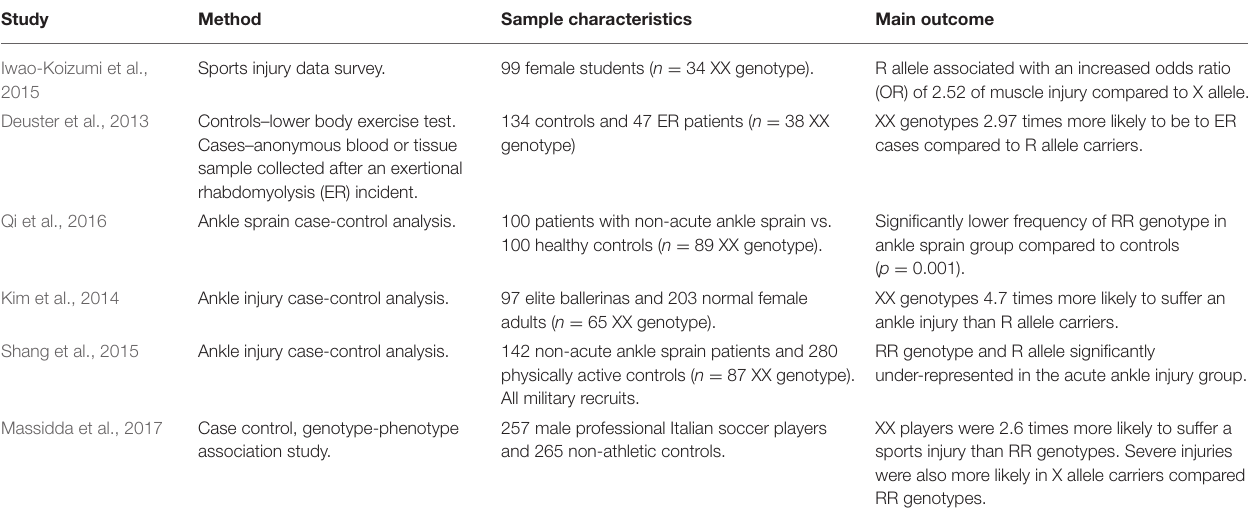
TABLE 3 | Studies examining the interaction between ACTN3 genotype and sports injury.